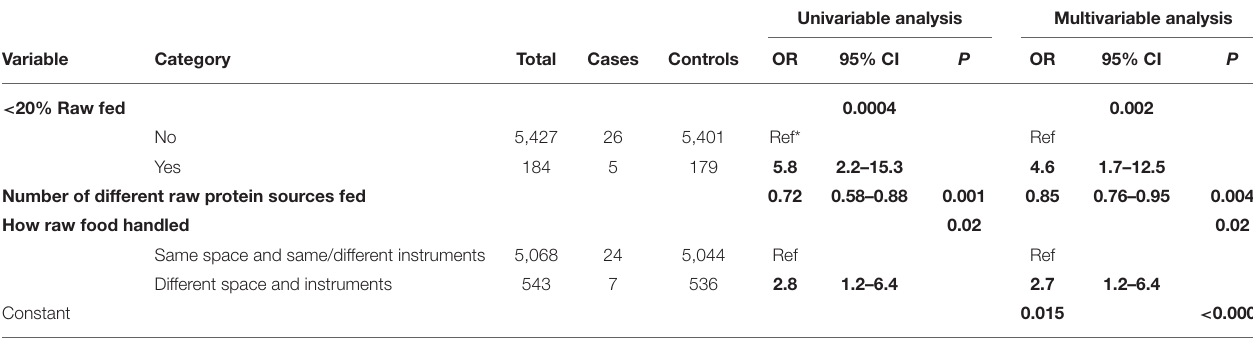
* Ref = Referent category. Nagelkerke R Square =